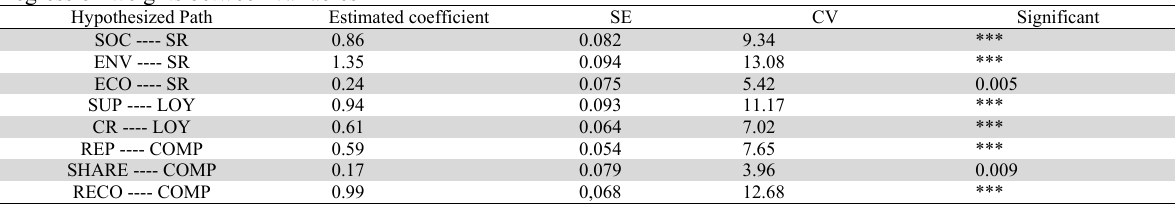
Regression weights between